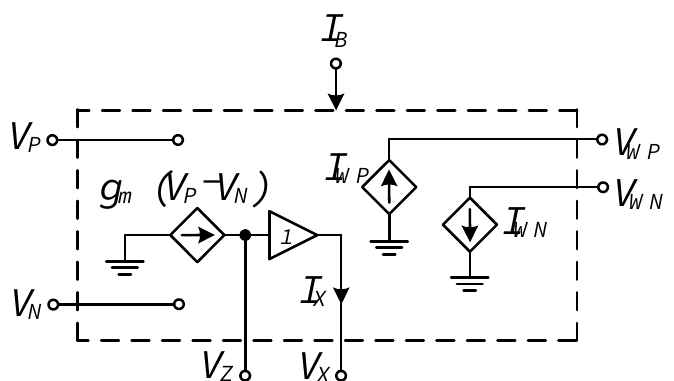
Figure 1. C ircuit symbol of VDCC. Figure 1. Circuit symbol of VDCC.